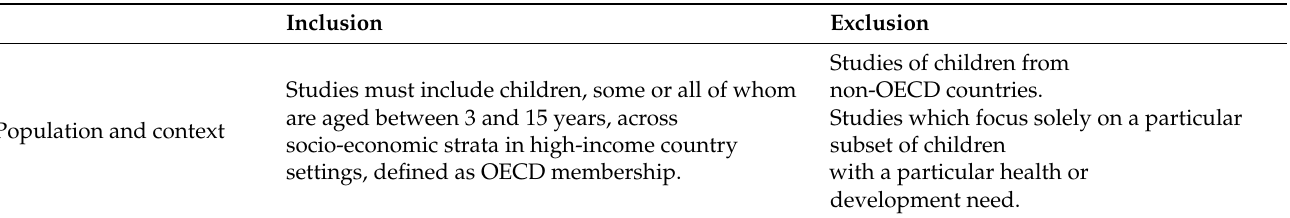
Table 1. Summary of eligibility